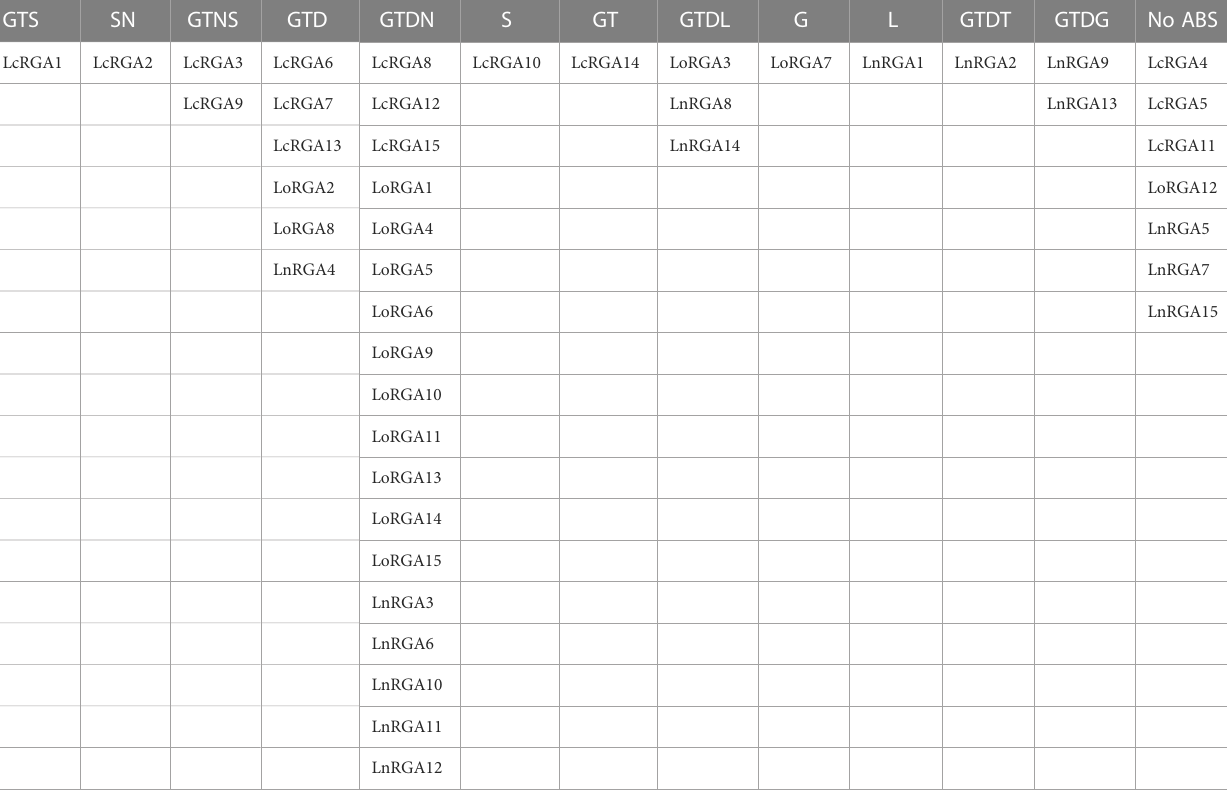
TABLE 4 Lentil RGAs grouped based on amino acid corresponding to predicted active binding sites